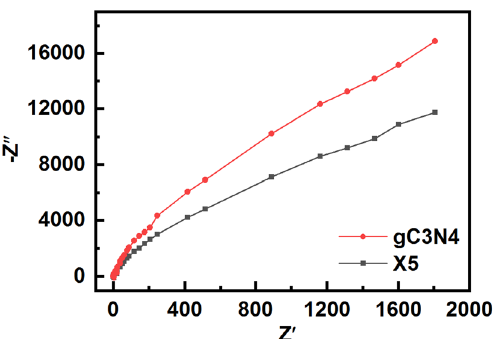
Figure 7. EIS of the pristine g-C 3 N 4 powders and the X5 composite powders.